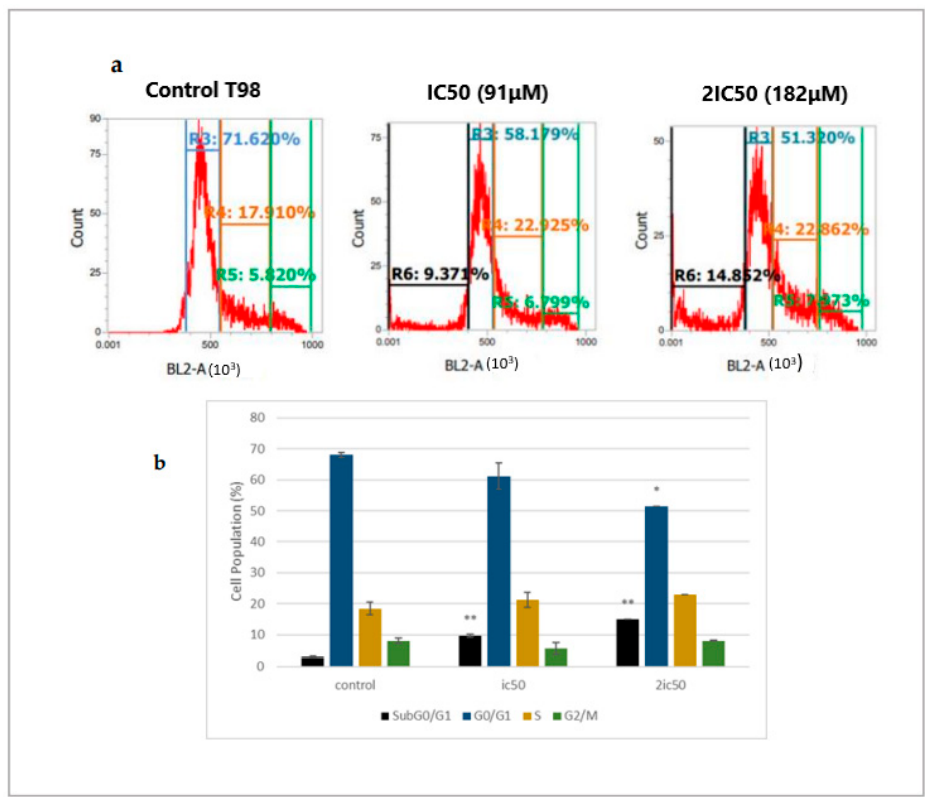
Figure 4. The regulatory effect of linearol on cell cycle distribution in T98 cells. ( a ) Linearol at concentrations of 91 and 182 µ M increased the S and SubG0/G1 populations 72 h post-treatment. ( b ) Cell cycle distribution of T98 cells after treatment with linearol and PI staining at 72 h. Cell populations at different cell cycle phases were quantified and data were expressed as mean ± SD from 3 different experiments. * p < 0.05; ** p < 0.001.